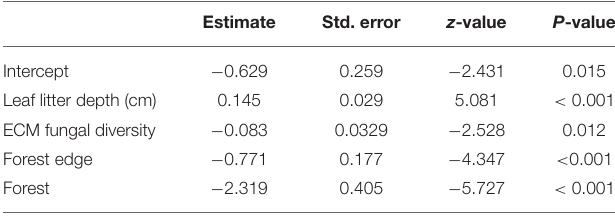
TABLE 2 | Binomial GLMM results of the effects of soil nutrients and properties on the proportion of canker incidence. Estimate Std. error z -value P -value